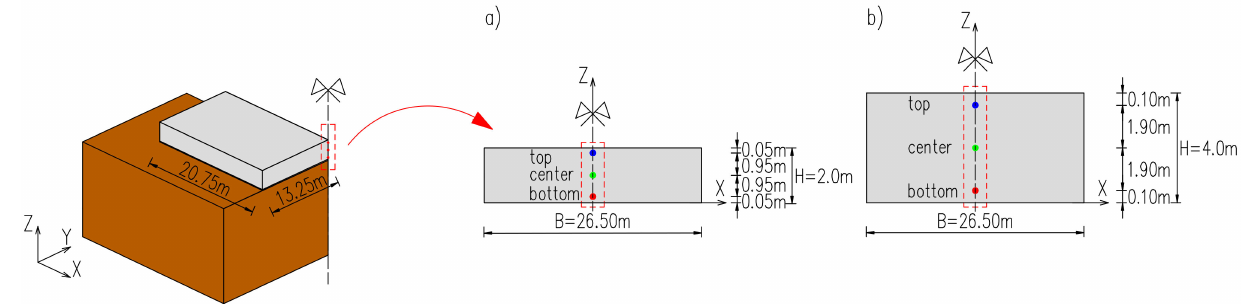
Figure 11. Locations of the reference points in the slabs of the thicknesses of ( a ) 2 m, ( b ) 4